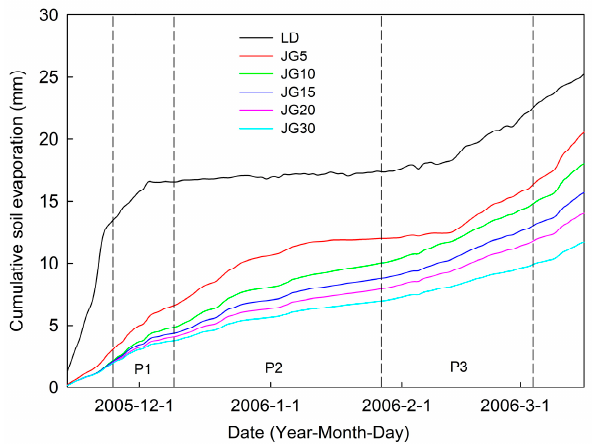
Figure 9. Cumulative soil water evaporation with different straw mulch thicknesses during the freeze–thaw period.